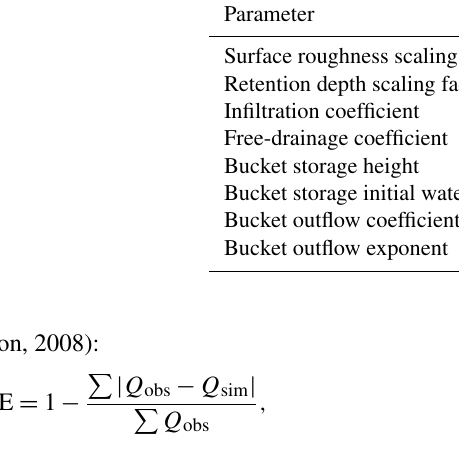
Table 2. List of parameters used for WRF-H_SA calibration. Parameter Abbreviation Sensitivity Compartment Surface roughness scaling factor OVROUGHRT Yes Overland routing Retention depth scaling factor RETDEPRT Yes Overland routing Infiltration coefficient REFKDT Yes LSM Free-drainage coefficient SLOPE Yes LSM Bucket storage height ZMAX Yes Baseflow model Bucket storage initial water ZINIT No Baseflow model Bucket outflow coefficient COEFF Yes Baseflow model Bucket outflow exponent EXPON Yes Baseflow